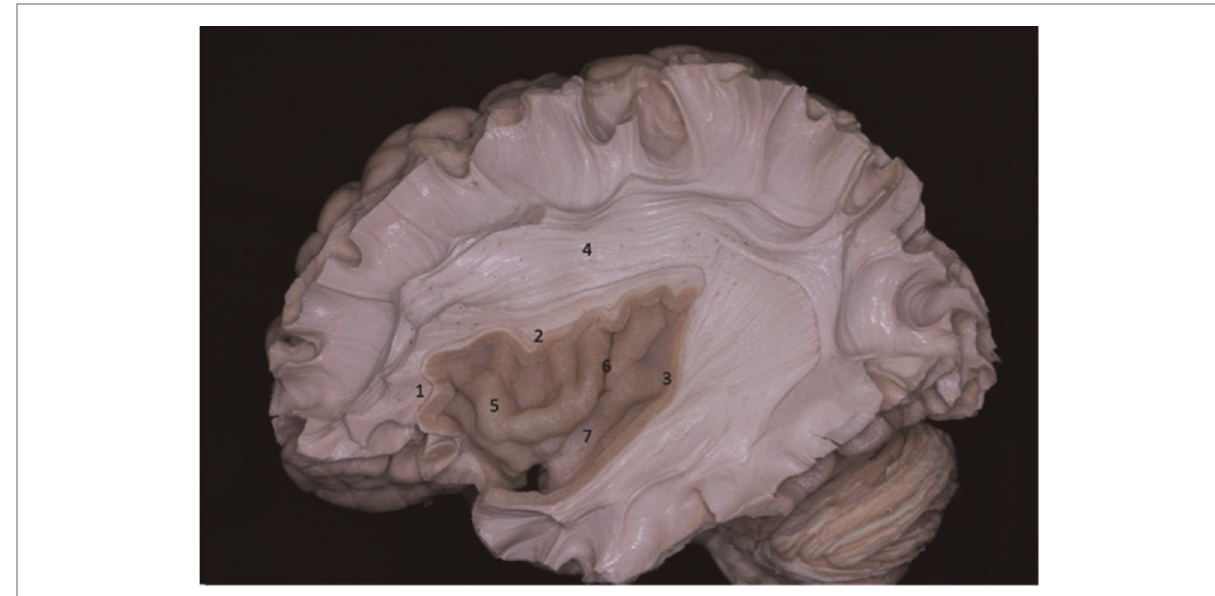
FIGURE 1 Lateral view of the left cerebral hemisphere after dissection of the cerebral cortex and its u- fi bers. The superior longitudinal fasciculus is observed around the insula. The lobe of the insula is pyramid-shaped with its apex oriented anteriorly and inferiorly. 1 - anterior circular sulcus; 2 - superior circular sulcus; 3 - posterior circular sulcus; 4 - superior longitudinal fasciculus; 5 - insular short gyri; 6 - insular central sulcus; 7 - insular long gyri.